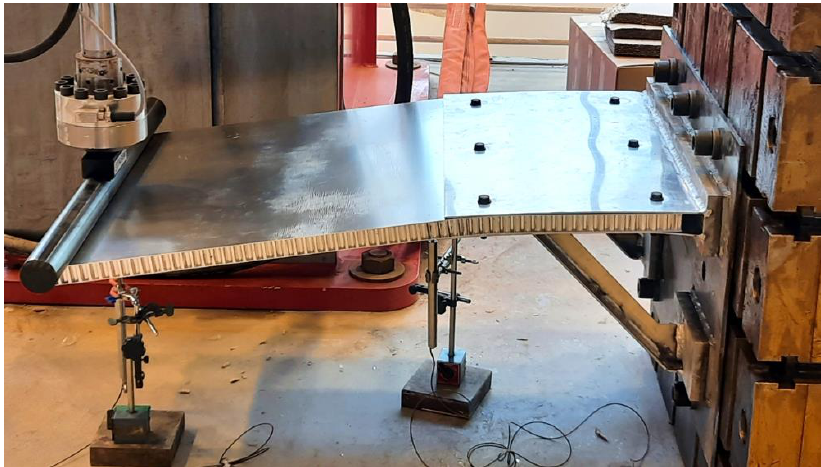
Figure 5. Experimental setup for full-scale testing of the AHS-based balcony overhang.